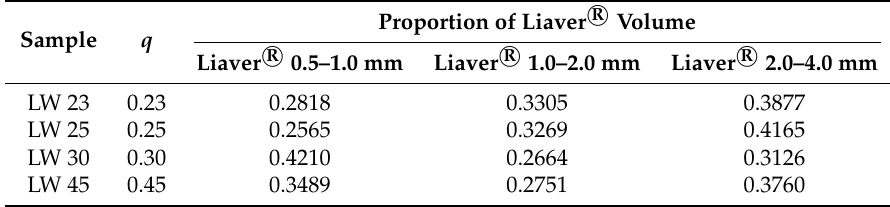
Figure 2. Gradings of different mixes (note: in this study, particles larger than 0.5 mm diameter are used for the specimens.). Table 3. Volume proportions of lightweight aggregates (Liaver R (cid:13) ) in each